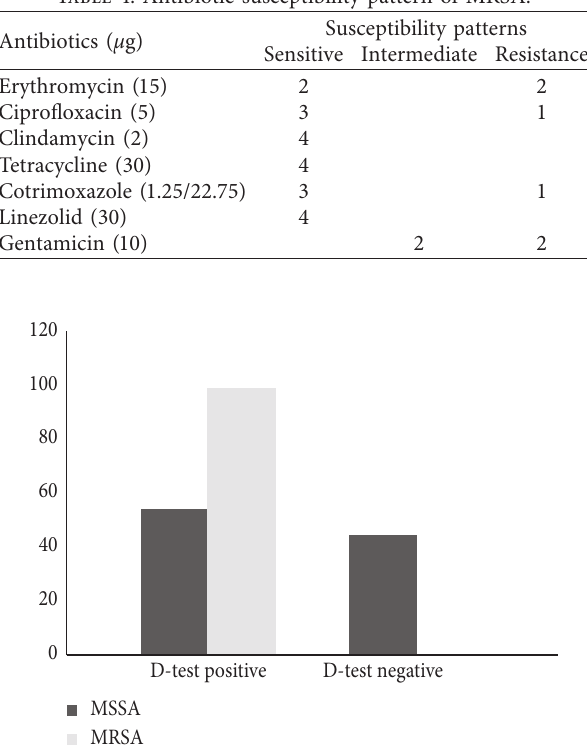
Figure 6: Inducible clindamycin resistance in MSSA and MRSA.